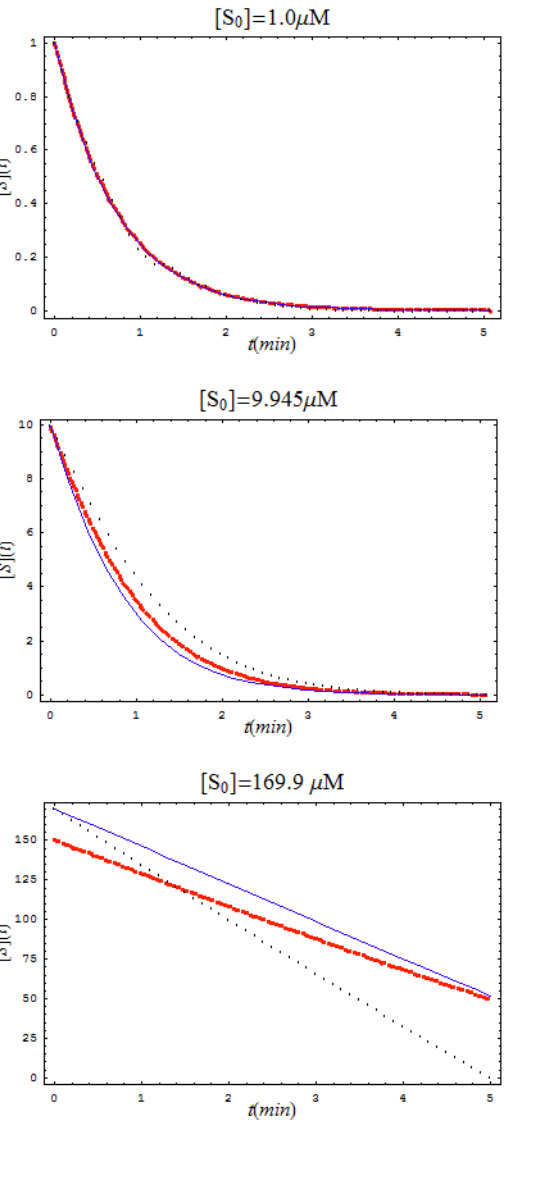
Figure 6. The W-Lambert and logistic progress curves as their fit with the experimental data for hydrolysis of various concentrations of butyrylthiocholine by a fixed concentration of butyrylcholinesterase according to the equations (55) and (57), through considering the kinetic parameters from (36) and (39) with the actual values K V = 7.2 µM/min; b = 3, for various initial substrate max